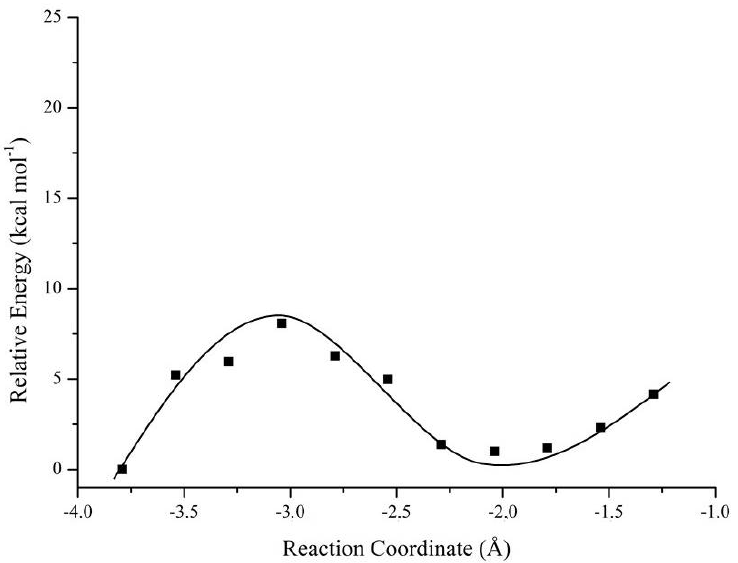
Figure 13. Graph of relative potential energy versus reaction coordinate for Soman ( S P enantiomer).